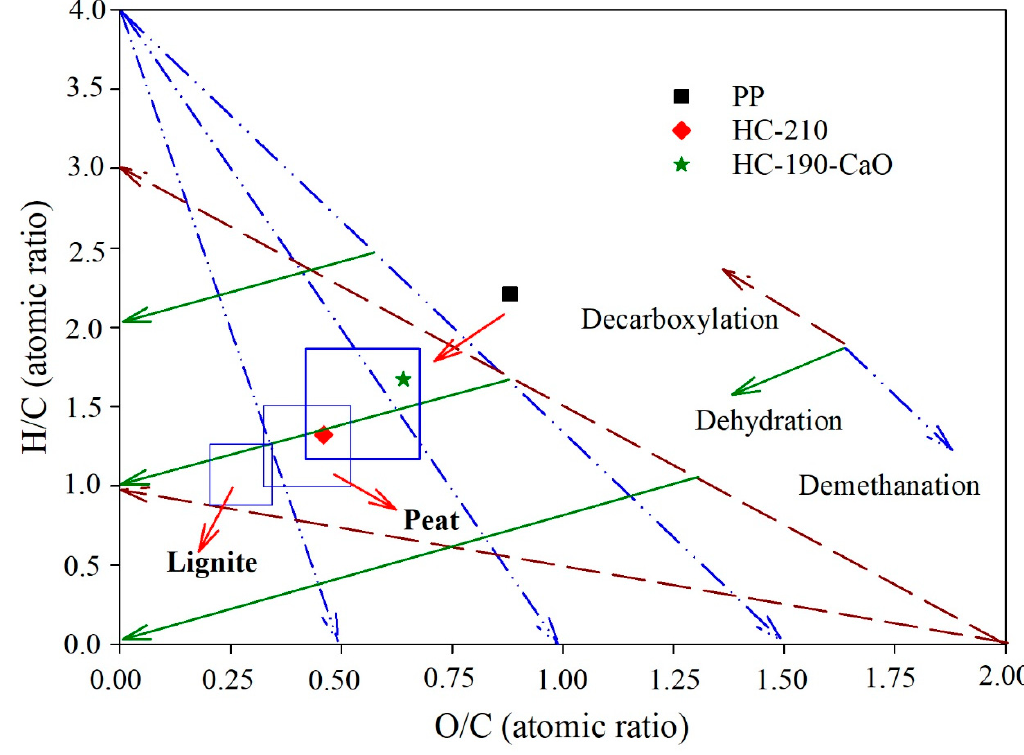
Figure 2. Van Krevelen diagram for raw PP and HC products.